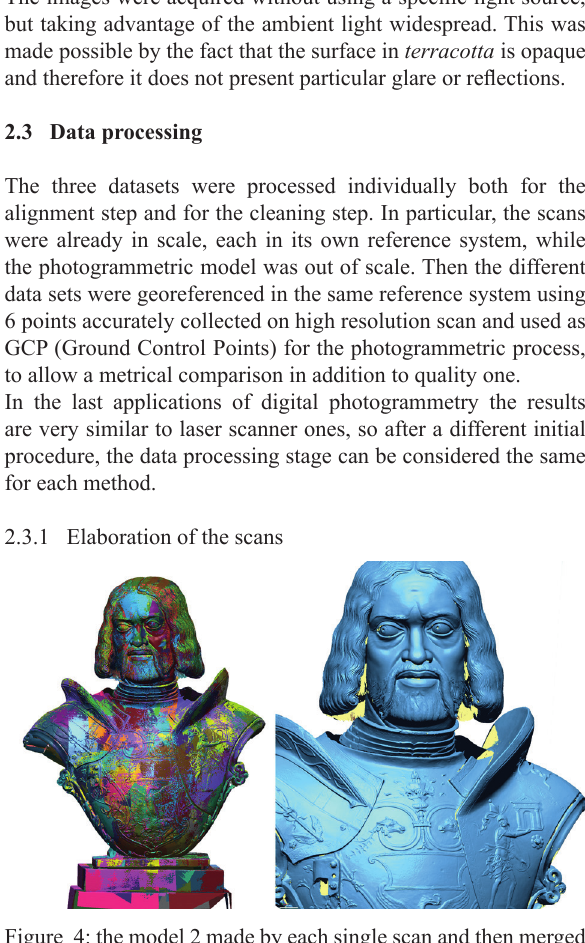
Figure 4: the model 2 made by each single scan and then merged in a single mesh. The missing part in yellow are evident and they are concentrated in the area under the head of hair.